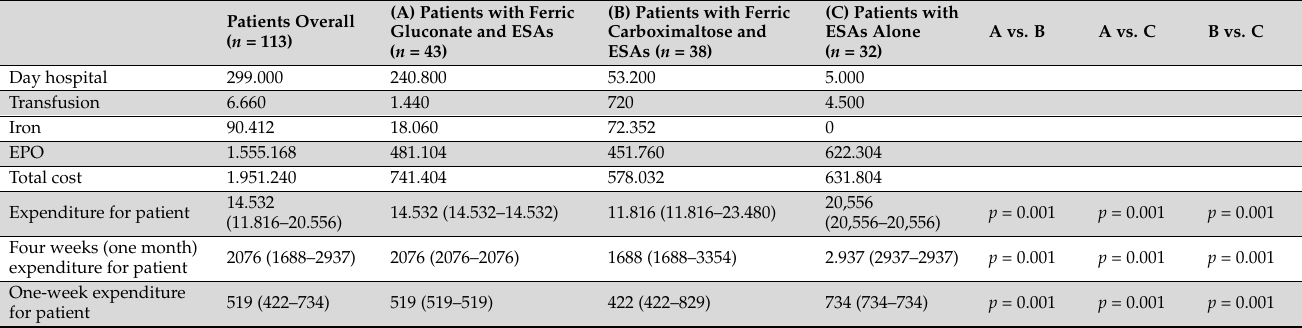
Table 2. Direct and indirect treatment-related cost (EUR) items. Data are reported as “median (IQR)”. Patients Overall ( n =